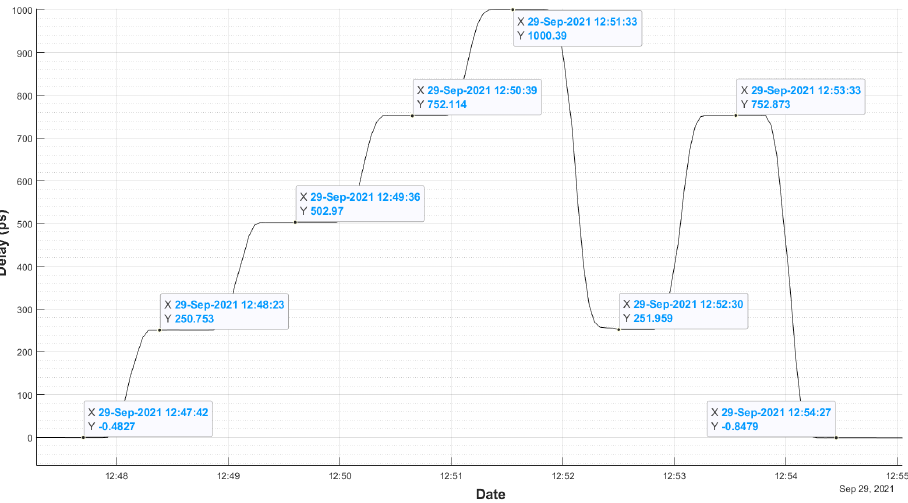
Figure 7. Phase Cal GU response to changes of 250 ps (two-way) controlled by a manual phase shifter.